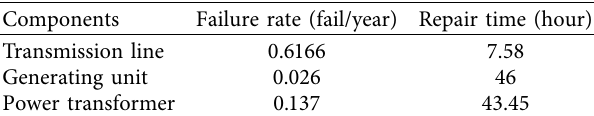
Table 4: Components reliability